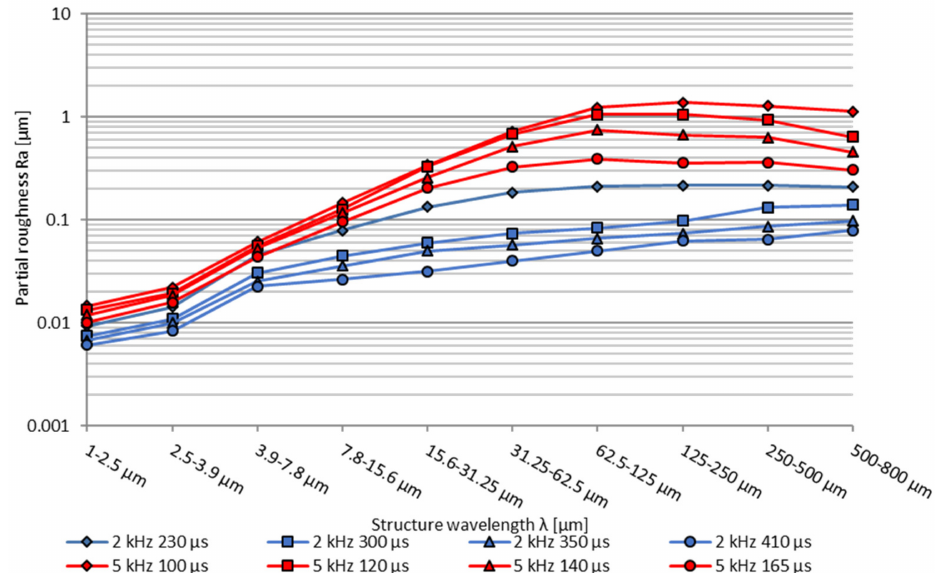
Figure 11. Partial roughness Ra, polished with modulation frequency f m = 2 kHz and 5 kHz depend- ing on the modulation time t m , measured in sample vertical direction (SVD).